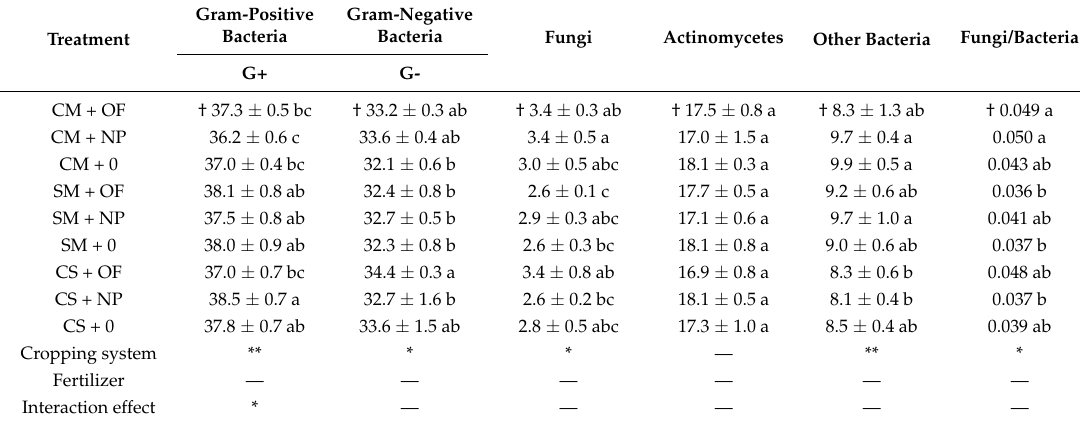
Table 4. Influence of each treatment on soil microbial community structure (%). Values are the average ± 1 standard error.